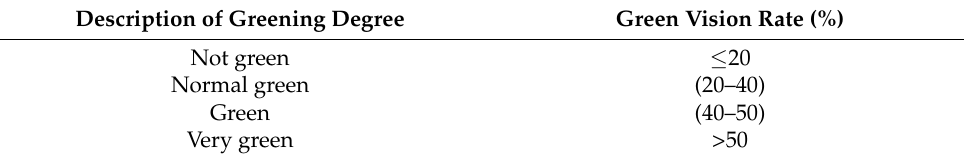
Table 3. Green vision rate.